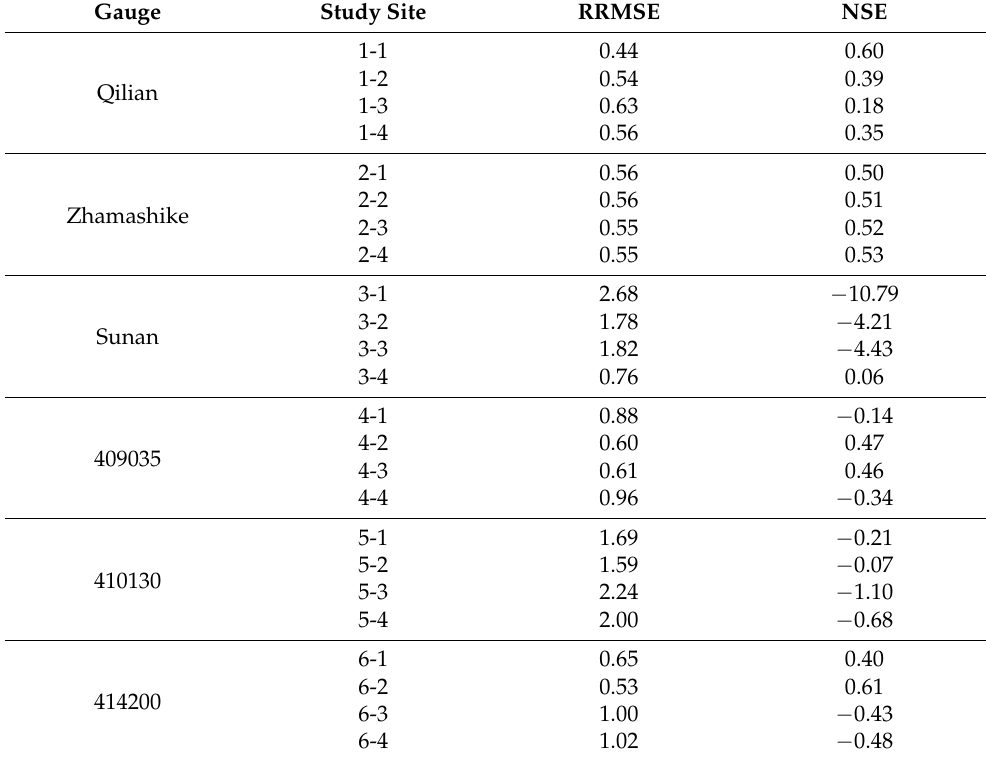
Table 3. The validation results of different hydrological